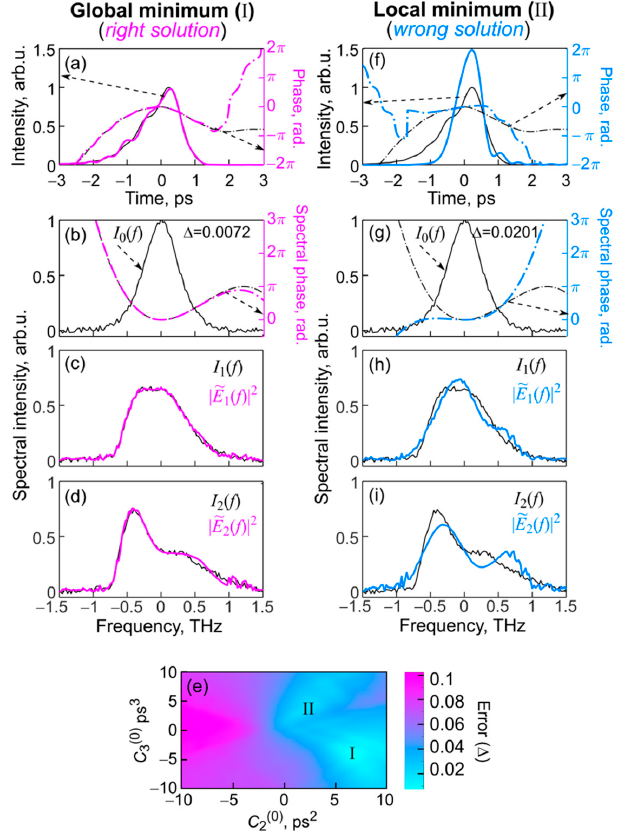
Figure 3. Search for polynomial spectral phase (by data with spectral noise). Search for polynomial spectral phase (ideal case). (( a – d ), left column) “Right” solution found for the global minimum I of the error function Δ ( C 2 = 6.5 ps 2 and C 3 = − 3.8 ps 3 ) shown in ( e ). (( f – i ), right column) “Wrong” solution constructed for the local minimum II of the error function Δ ( C 2 = 2.4 ps 2 and C 3 = 3.9 ps 3 ) shown in ( e ). ( a , f ) Intensity and phase in the time domain; ( b , g ) input pulse spectrum and spectral phase; ( c , h ); converted spectra at the output for B 1 = 1; ( d , i ) converted spectra at the output for B 2 = 2. Black curves calculated for the initial pulse and color (magenta and blue) curves correspond to numerically reconstructed pulses for subplots ( a – d , f – i ).